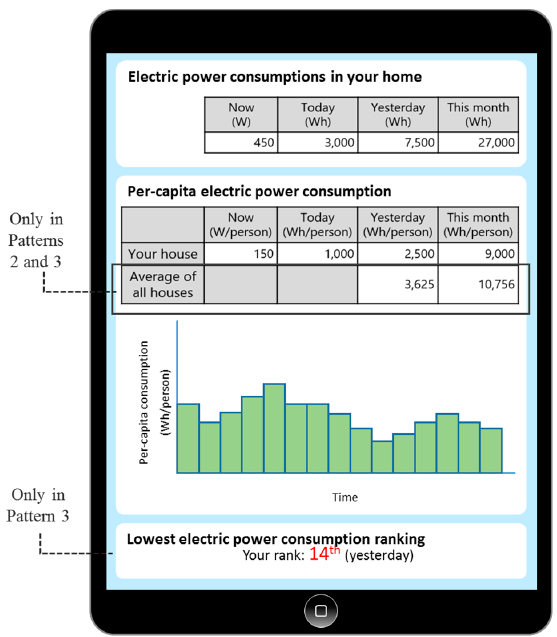
Figure 3. Information feedback on tablet PC. Source: Shimada et al. (2015) [13].